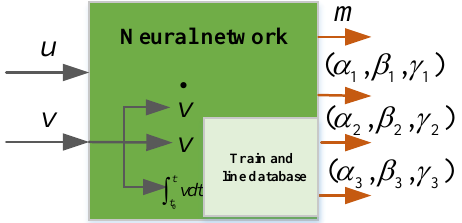
Figure 4. Neural Network learning module structure.